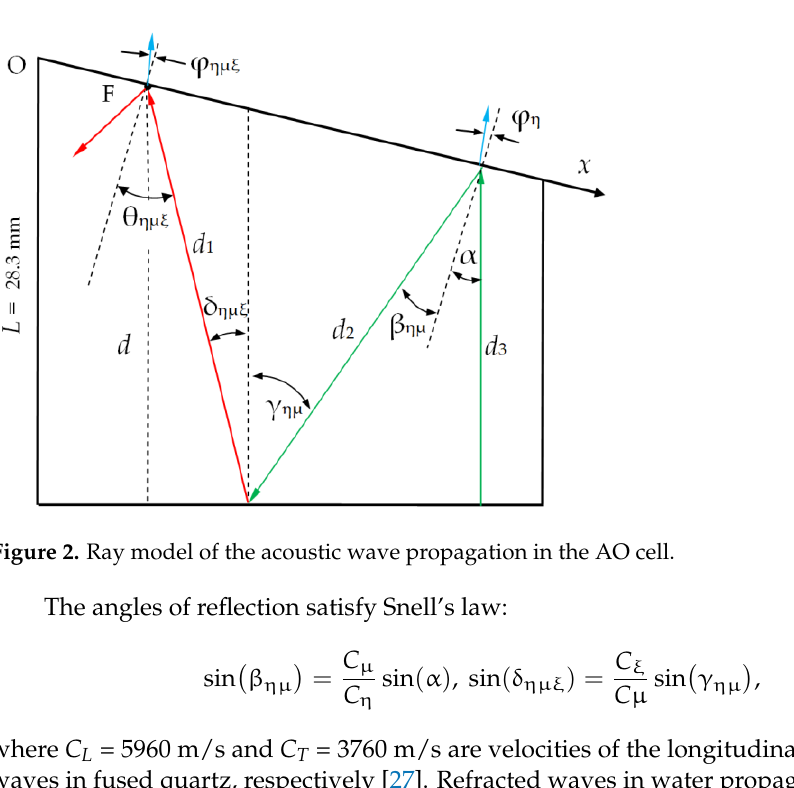
Table 1. Calculated and experimental values of angular, temporal and slowness parameters of wave propagation.